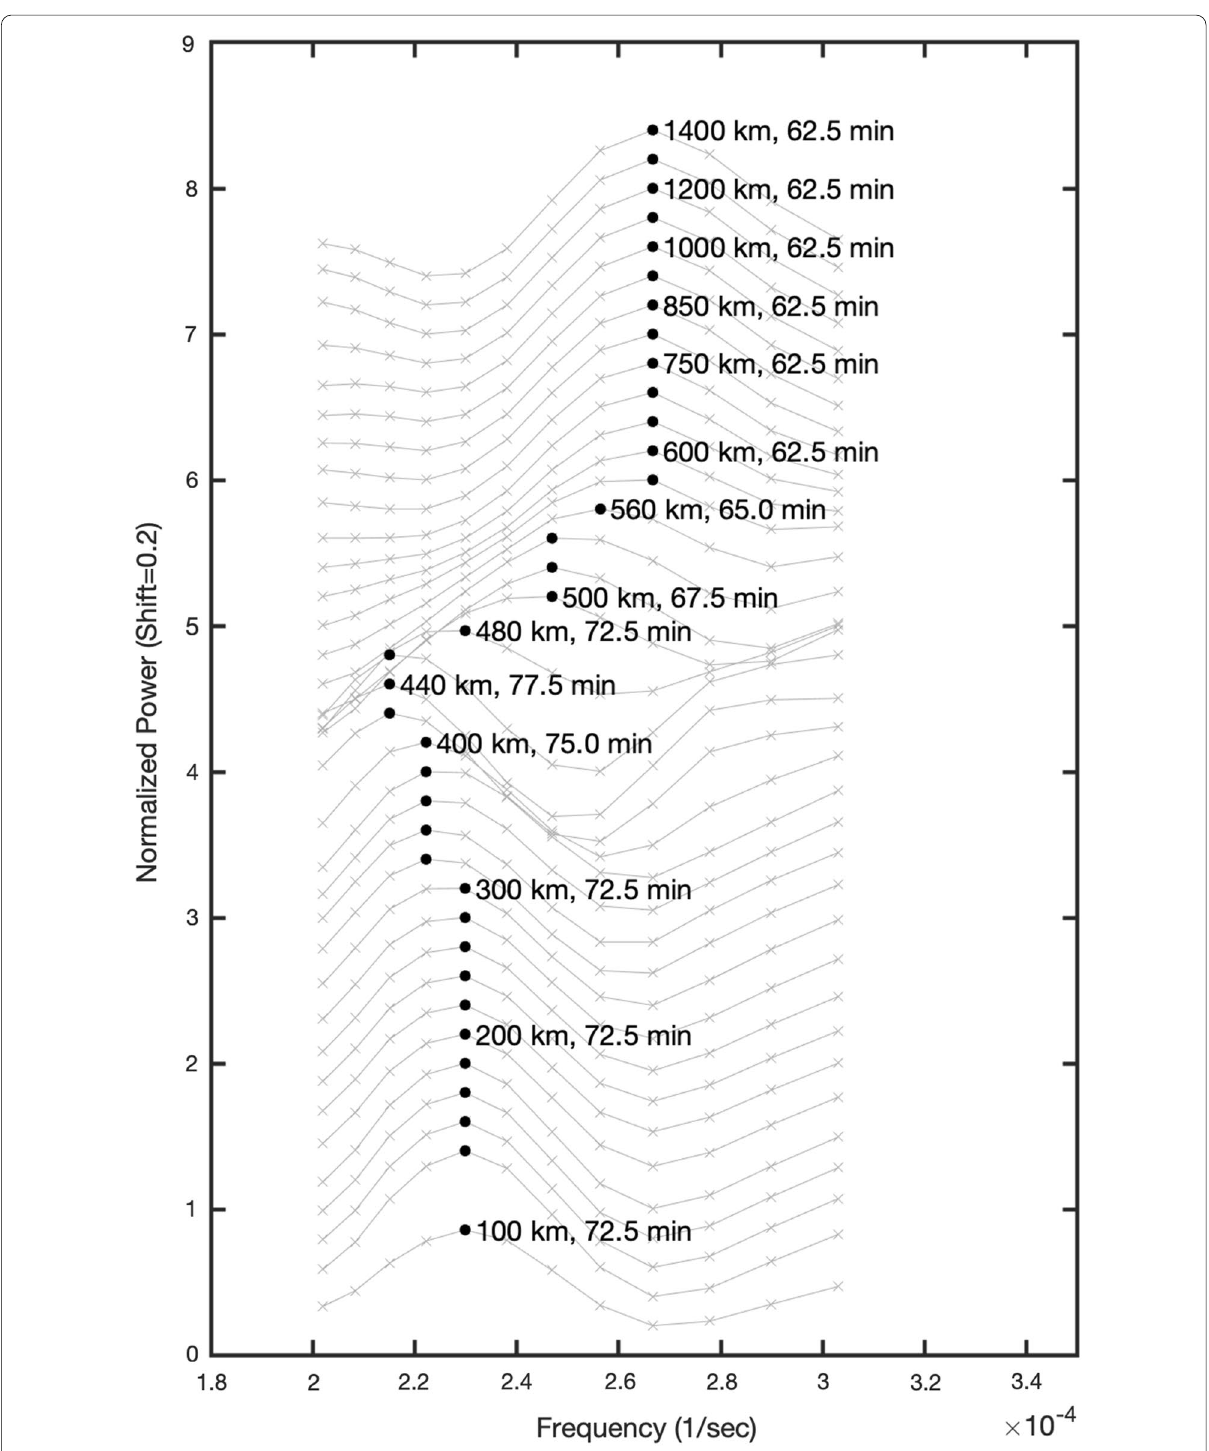
Fig. 6 The normalized power spectra of temporal variations in the electron density on the eclipse day at various altitudes. The black dot denotes the center frequency (period) of each pronounced wave. In order not to overlap the spectrum results at each altitude, the shift value of 0.2 is added in each